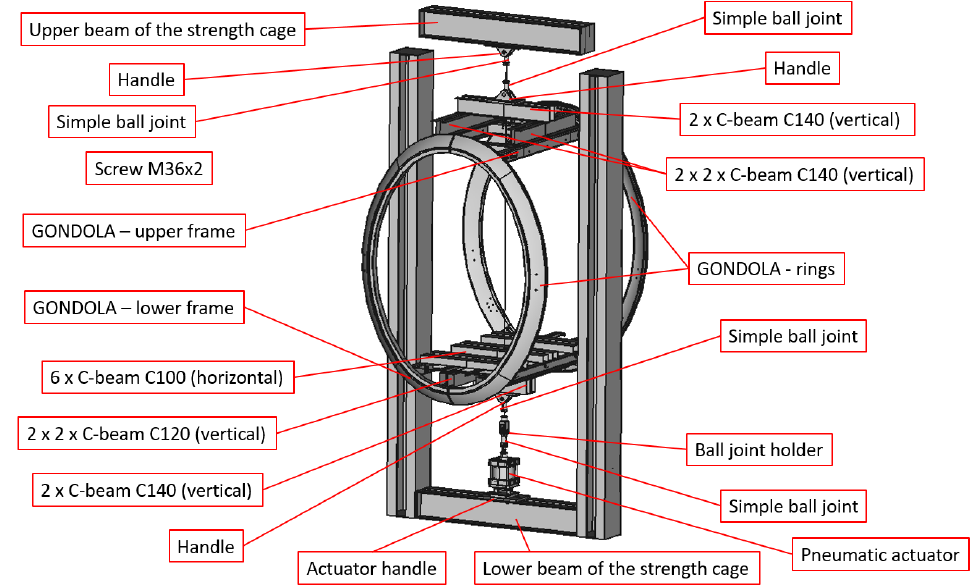
Figure 5. Geometric model of the gondola with the most important assembly elements marked (screw connections